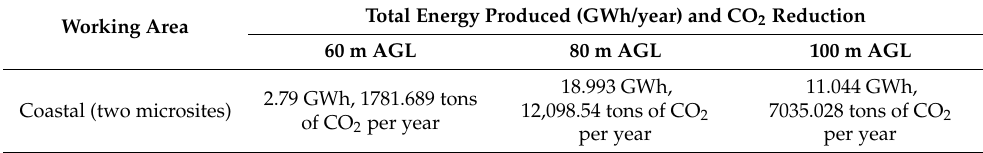
Table 15. CO 2 emission reductions for different types of WTGs at different